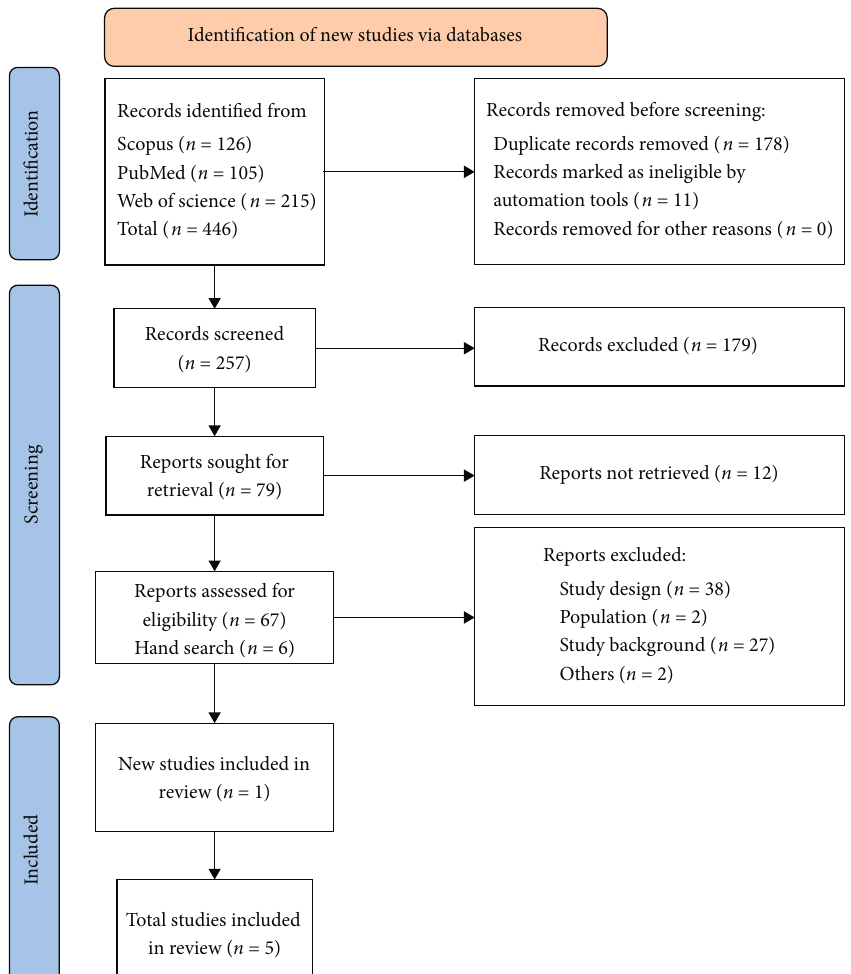
Figure 1: Selection process of studies regarding diabetic foot lesions and stem cell therapy. Shows the process of study selection that includes identi fi cation and screening until the fi nal inclusion of data for